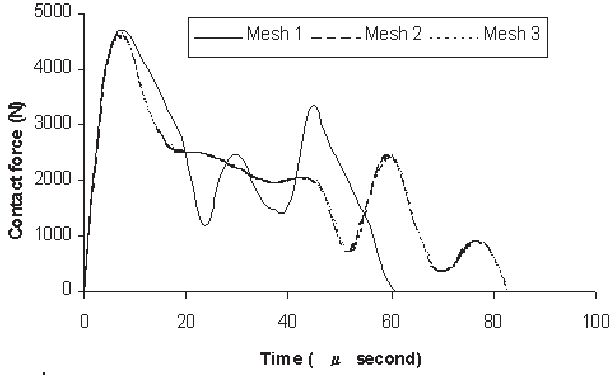
Fig. 12. Variation of adaptive contact force (line contact) on composite plate with respect to